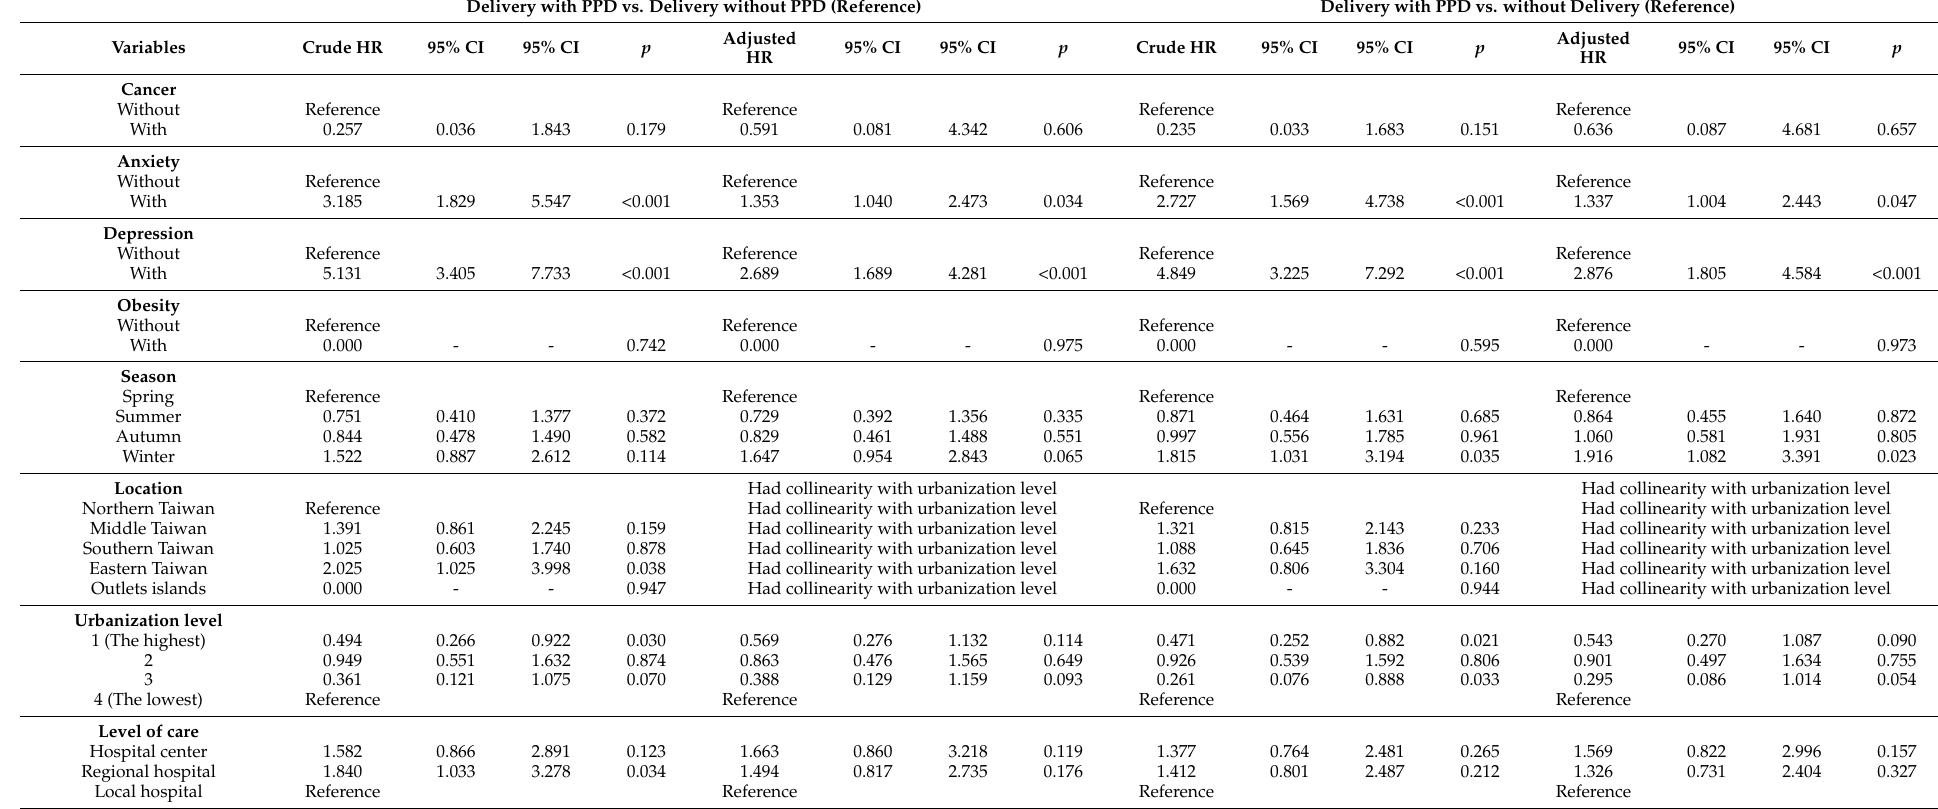
Table 2. Cont . Delivery with PPD vs. Delivery without PPD (Reference) Delivery with PPD vs. without Delivery